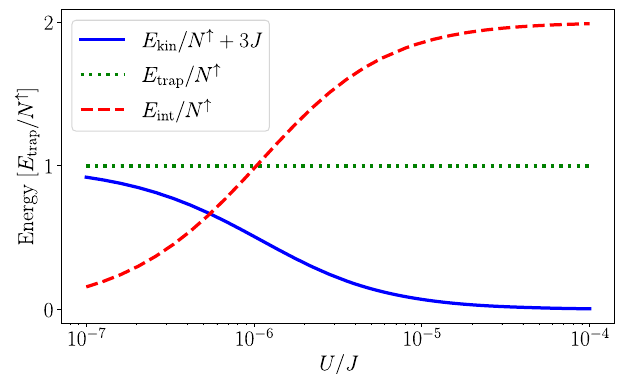
Fig. 4 Mean- fi eld energy contributions. Comparison of the energy contributions (in units of the harmonic trap energy) as a function of the onsite interaction U , for N x = 601 sites, a strength of harmonic con fi nement V x = 10 − 6 J / a 2 and N ↑ = 1.2 × 10 5 bosons. The Thomas – Fermi regime is reached when the kinetic energy E kin is negligible with respect to both the energy from the harmonic potential E trap and from the interactions E int , i.e. for suf fi ciently high values of U . The kinetic energy is shifted by 3 J in order to measure the energy from the bottom of the band.